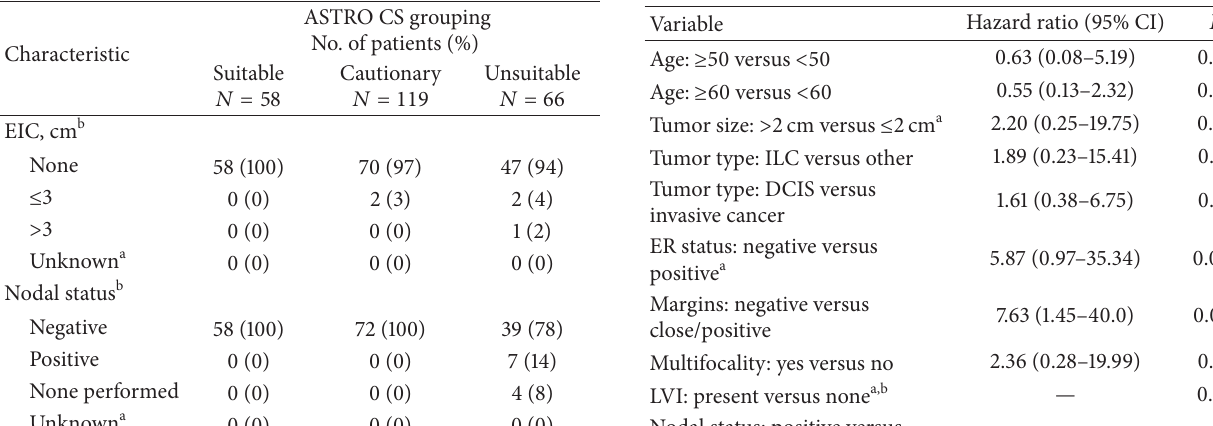
Table 3: Factors associated with ipsilateral breast tumor